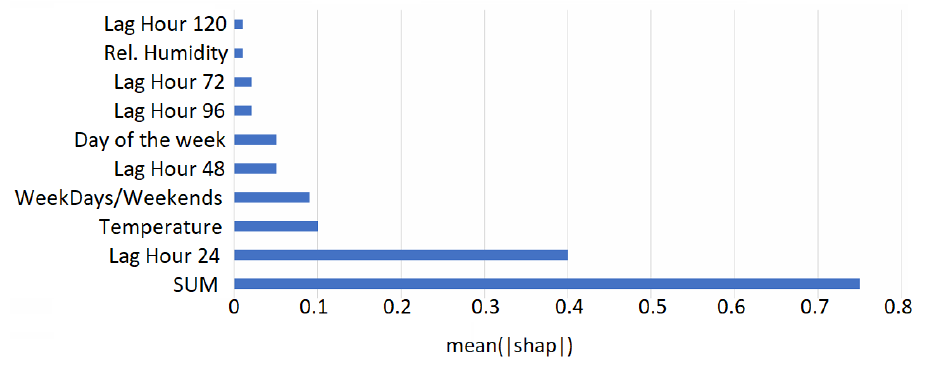
Figure 16. Influence of features in the support vector regression